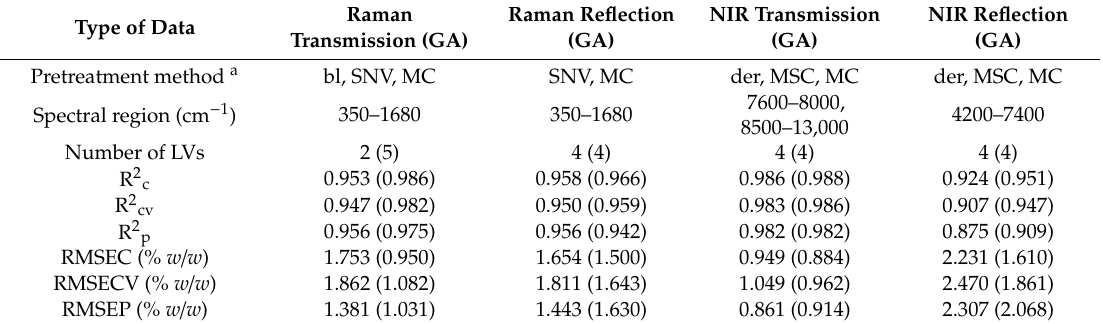
Table 3. ParametersofthemodelspredictingHPMCcontent(modelsgainedafterGArunsareinparentheses). Type of